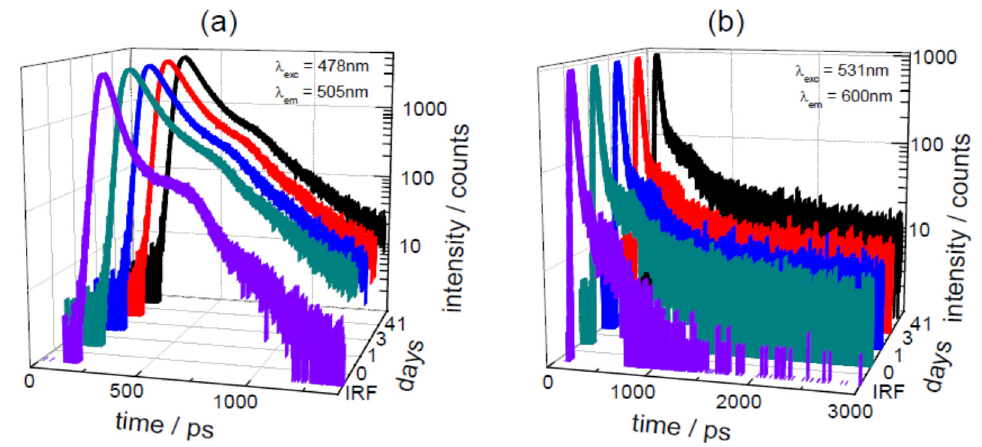
Figure 8. Time-resolved decays for the beetroot samples stored for different times; ( a ) using 478 nm excitation; ( b ) with 531 nm excitation. The IRF in both cases is also shown (FWHM of 77 ps at 478 nm and 52 ps at 531